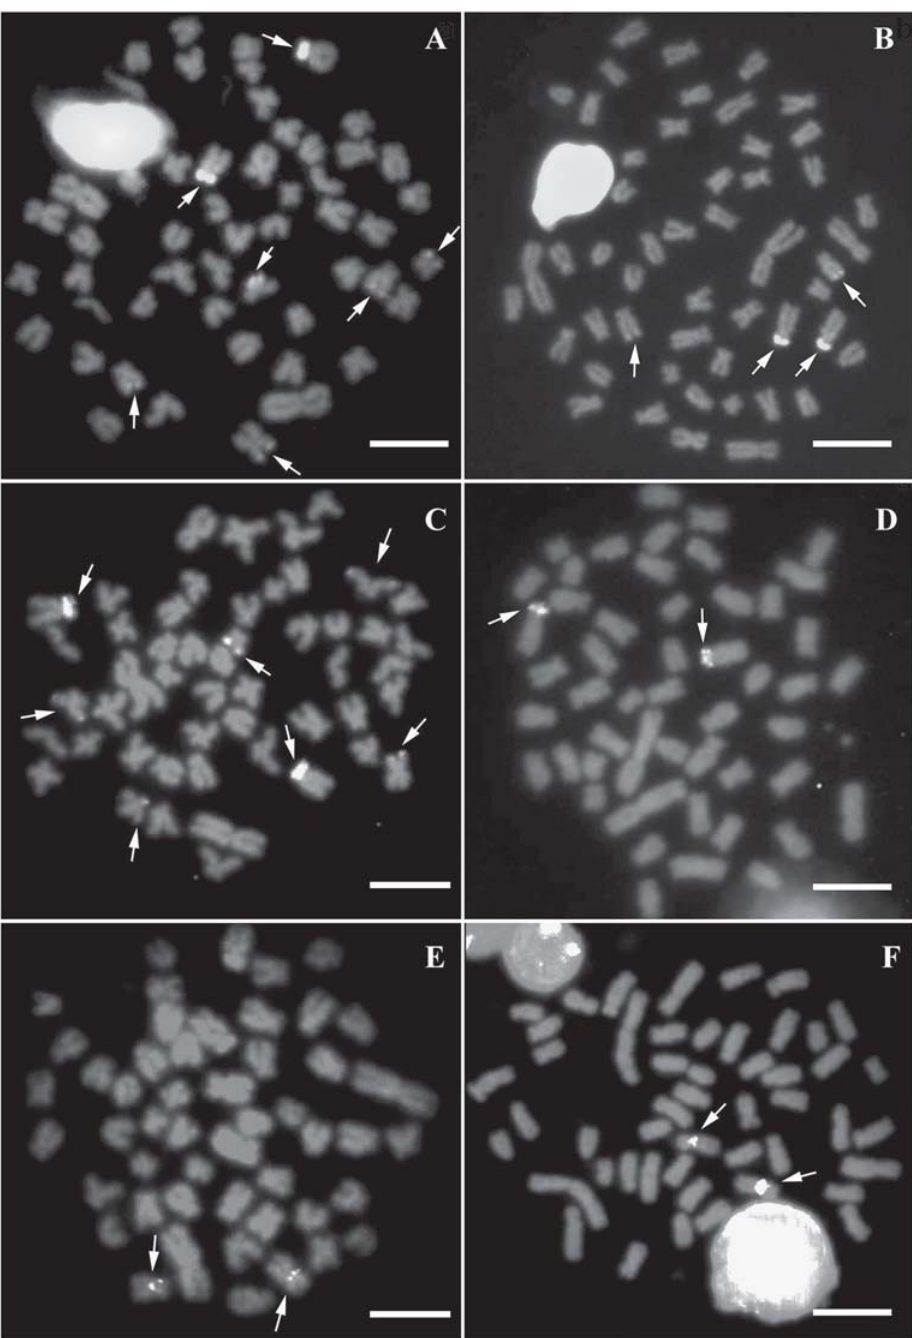
Fig. 3. Metaphases of Astyanax altiparanae . Chromomycin A 18S rDNA by FISH (C; D) and 5S rDNA by FISH (E; F) for the upper rio Tibagi and upper rio Iguaçu populations, respectively. Bar=5 µ